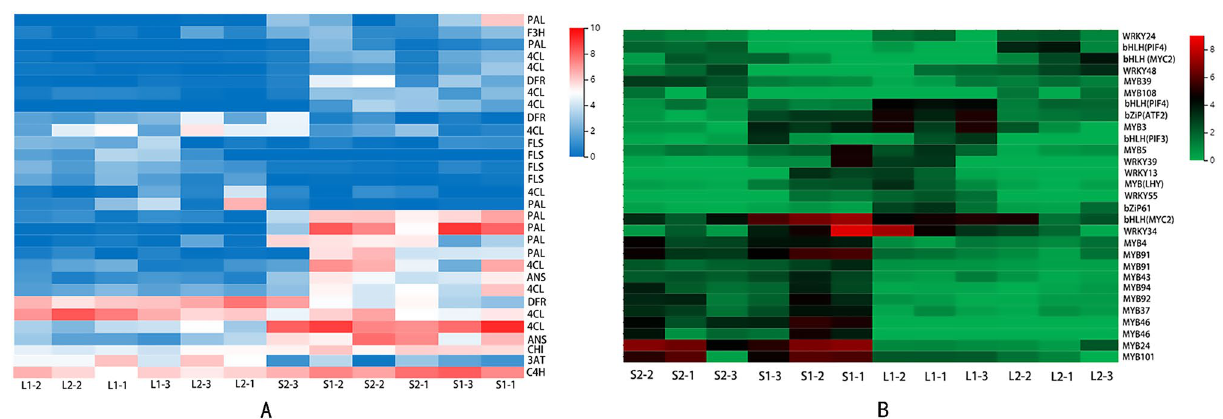
Figure 3. (A) Expression patterns of flavonoids biosynthetic genes in stems and leaves samples of S. miltiorrhiza . (B) Expression of flavonoids biosynthetic transcription factors in nine samples of S. miltiorrhiza . The horizontal axis represents log2 (FPKM + 1) of the sample and the vertical axis represents genes. L1(green leaf), L2(the leaves with purple edges), S1(green stem), S2 (purple